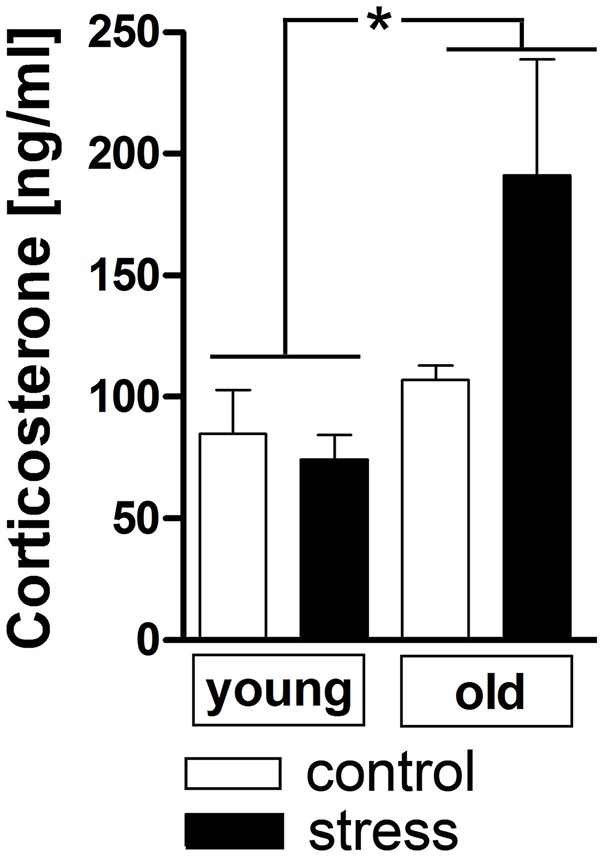
Plasma corticosterone levels after 90 min in stressed and unstressed young and old male rats. Aged rats displayed increased corticosterone levels after psychological stress, while the plasma levels of young rats remained unchanged. *main effect of age; *P < 0.05. Control young n = 7, stress young n = 4, control old n = 5, stress old n = 5.